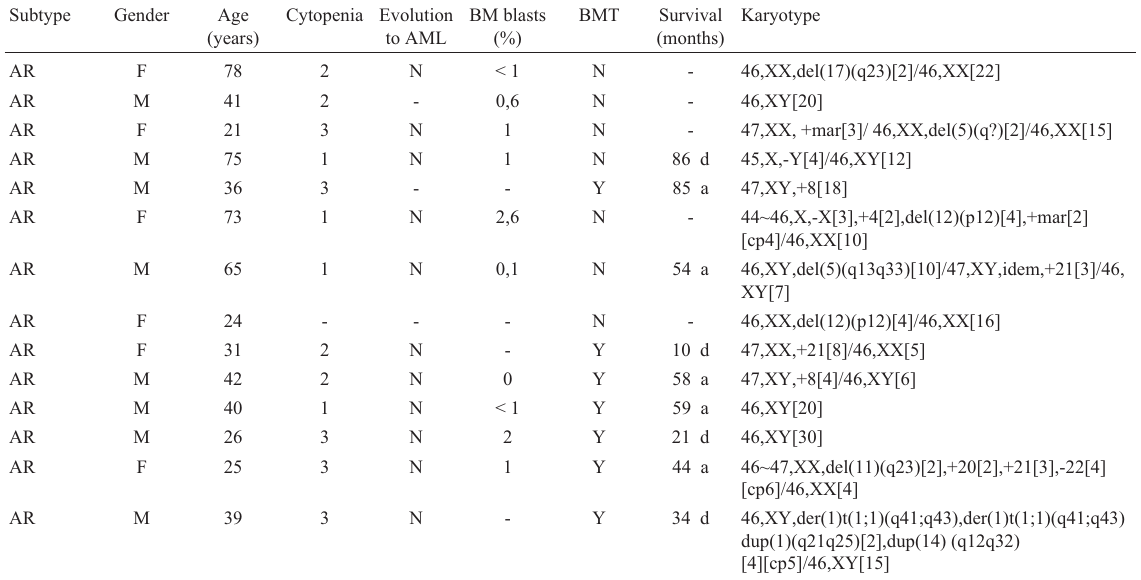
Table 1 - Clinical data and karyotype of 66 adult MDS patients.